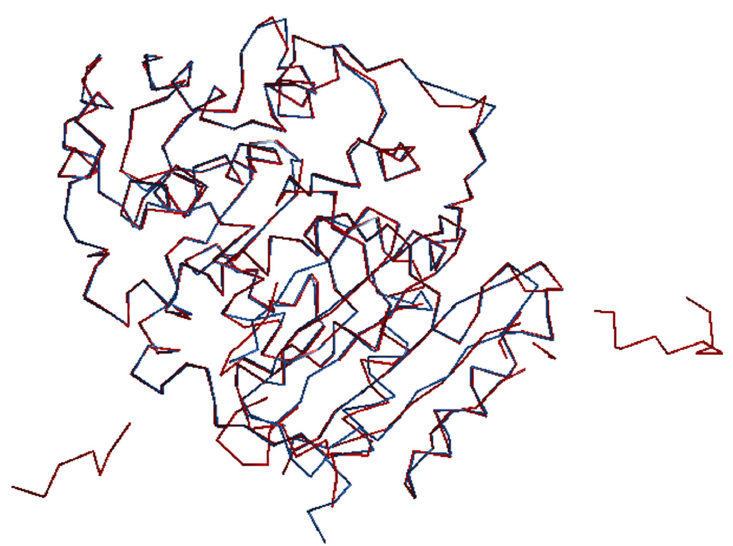
Figure 2. 3zyt , MA = 0.81, SI = 0.22. CAB chain-trace in red, published chain-trace in blue. CAB and the published backbones coincide in most of the target asu.